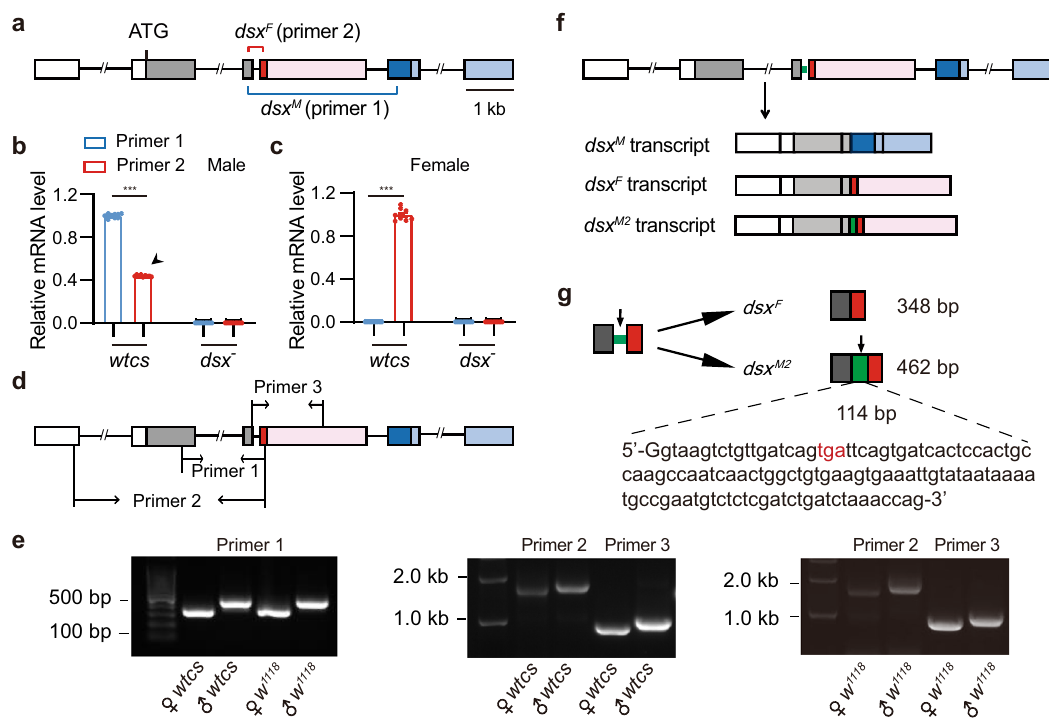
Fig. 1 Identi fi cation of a male-speci fi c dsx M2 transcript through intron retention. a Schematic structure of the dsx gene. Boxes: exons; white and gray boxes: common 5 ’ -UTR and coding sequences respectively in both sexes; red and pink: coding and 3 ’ -UTR sequences of the female-speci fi c exon; dark and light blue: coding and 3 ’ -UTR sequences of male-speci fi c exons. Primers against sex-speci fi c sequences are indicated. b , c Relative mRNA expression levels of presumed dsx M cycle at 60% humiditytranscript ( b , primer 1) and dsx F transcript ( c , primer 2) in wtcs and dsx mutant ( dsx 683-7058 /dsx 1649-9625 ) males and females. n = 9 based on three replicates for each. *** p < 0.001, Mann – Whitney U test. Note that a dsx transcript (arrowhead) is detected in males using the primer against the female-speci fi c transcript ( b ). d , e Reverse transcription PCR (RT-PCR), using three pairs of primers as indicated ( d ), and sequencing identify the male-speci fi c dsx M2 transcript, in addition to the female-speci fi c dsx F transcript, in both wtcs and w 1118 fl ies ( e ). For primer 1: 462bp and 348bp for male and female products, respectively; for primer 2: 1833bp and 1719bp for male and female products, respectively; for primer 3: 1069bp and 955bp for male and female products, respectively. f Illustration of the male-speci fi c dsx M2 transcript, in addition to previously identi fi ed dsx M and dsx F transcripts. g The dsx M2 transcript differs from the dsx F transcript with the 114 bp intron (in green) retained. Red letters (tga) indicate the stop codon inside the retained